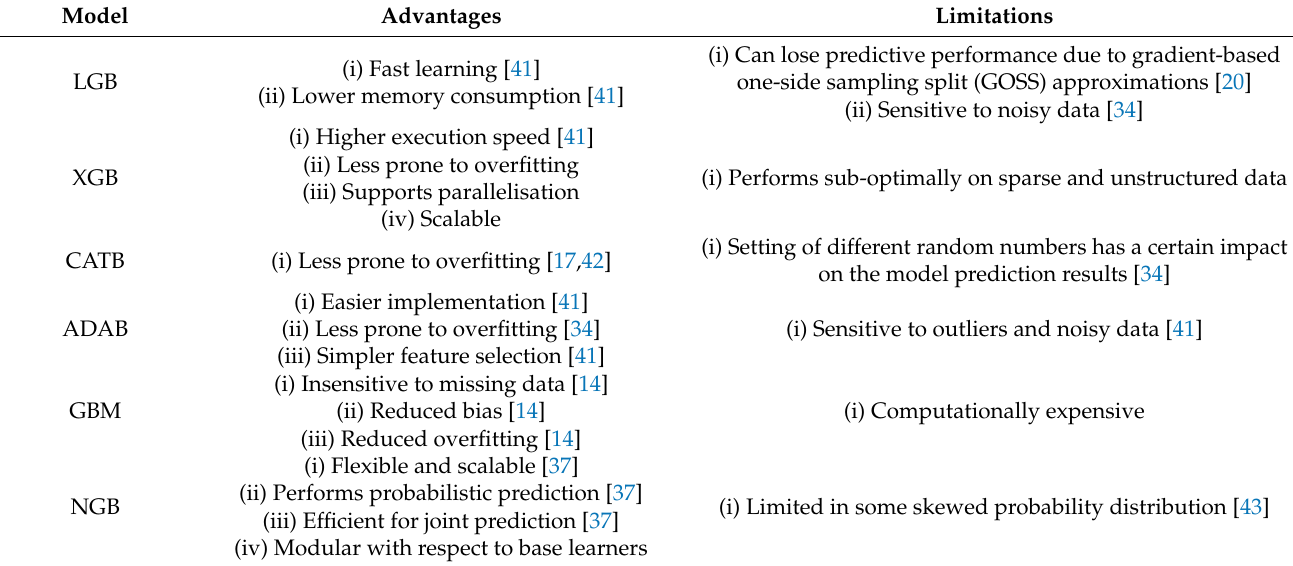
Table 2. Summary of advantages and limitations of the boosting algorithms used in the